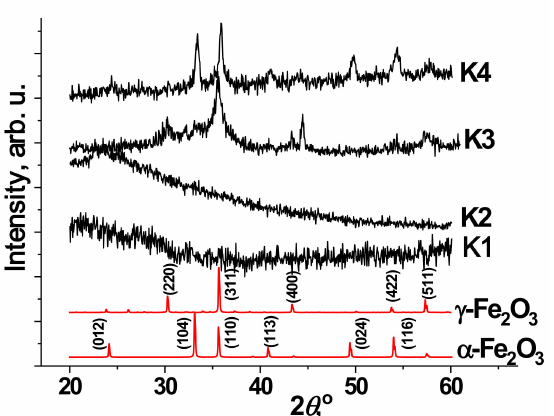
Figure 1. Diffractograms of synthesized material, after annealing at different temperatures and the model γ -Fe 2 O 3 (JCPDS cards 39-1346) and α -Fe 2 O 3 (JCPDS card